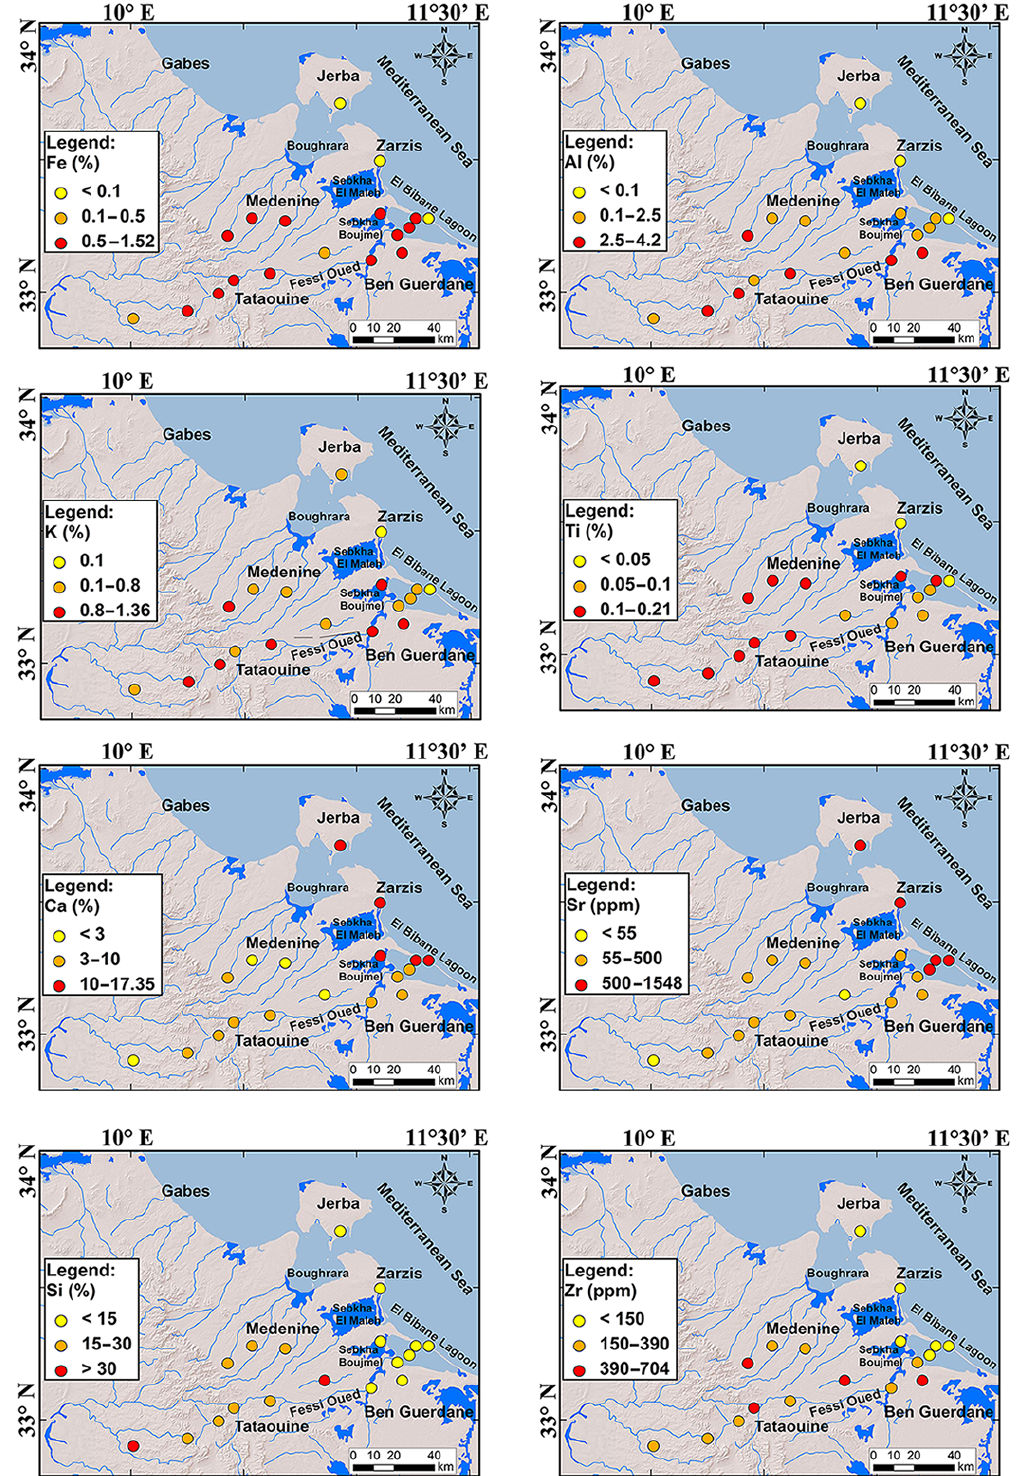
Figure 7. Distribution map of major and trace elements in surface sediments from the catchment basin and the El Bibane Lagoon.